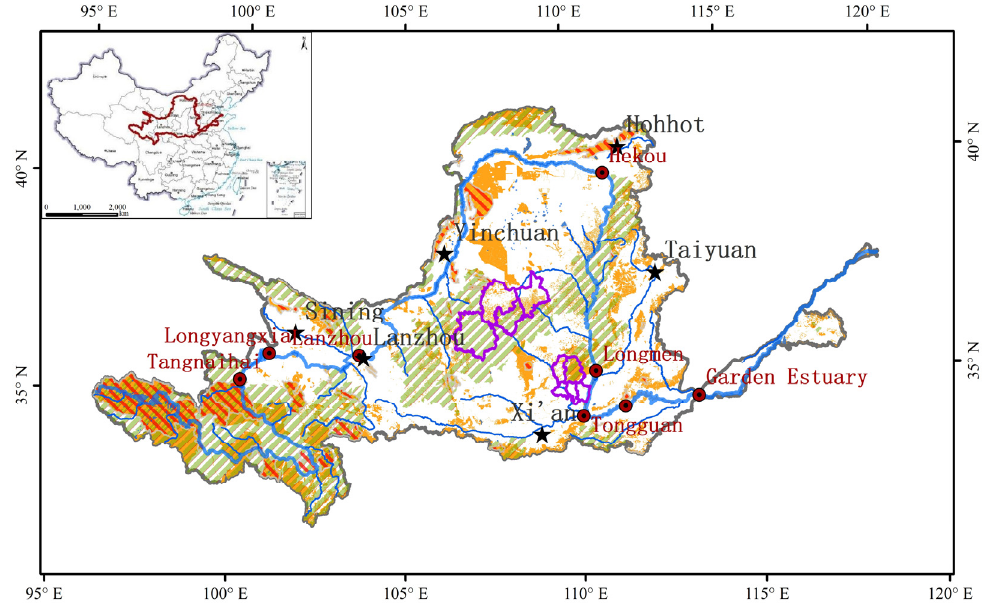
Figure 1. The areas of interest in the YRB mainly include national nature reserves (NNR), China Ecological Conservation Red Lind (CECRL), key ecological function regions (KEFR) and the typical areas.